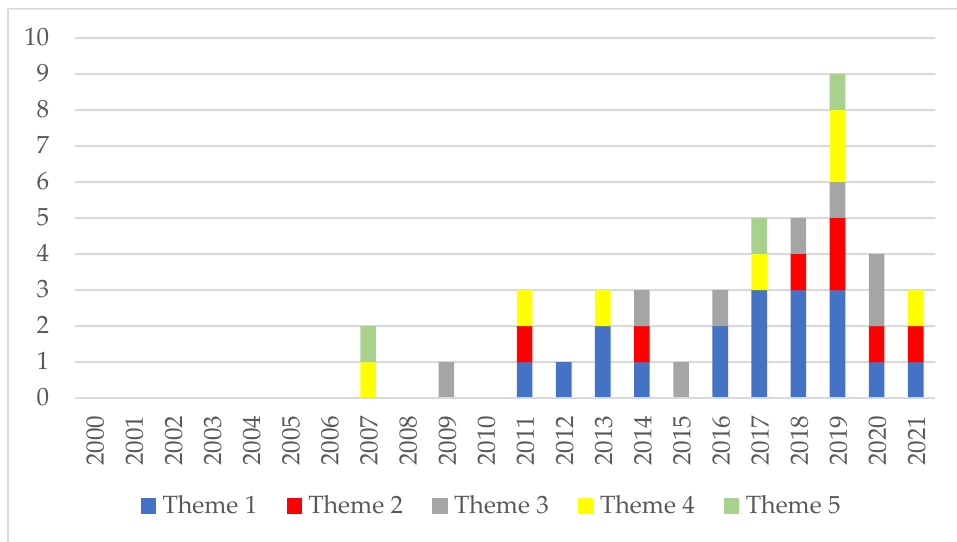
Figure 6. Distribution of articles based on research themes by year ( n = 43): Theme 1 (the physicality of urban green space); Theme 2 (The experience of urban green space); Theme 3 (the valuation of urban green space); Theme 4 (The management of urban green space); Theme 5 (the governance of urban green space).